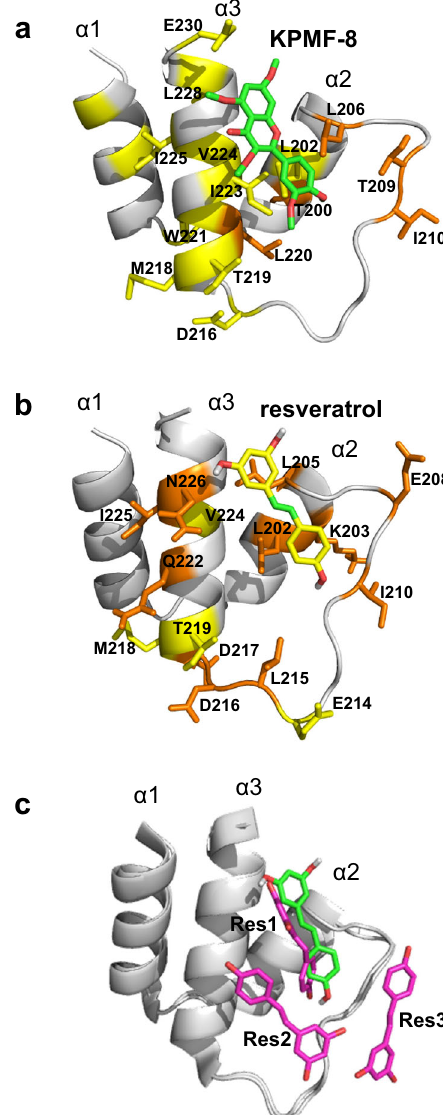
Fig. 6 The binding model of SIRT1 NTD to KPMF-8 or resveratrol, predicted based on the structure of SIRT1 (PDB: 4ZZH) through Autodock Vina. SIRT1 NTD residues that undergo large and moderate chemical shift changes by the addition of a KPMF-8 or b resveratrol are highlighted in orange and yellow, respectively. c Alignment of the resveratrol molecule docked to the SIRT1 NTD in this study (green) and the three resveratrol molecules bound to the SIRT1 NTD in the crystal structure (PDB: 5BTR)